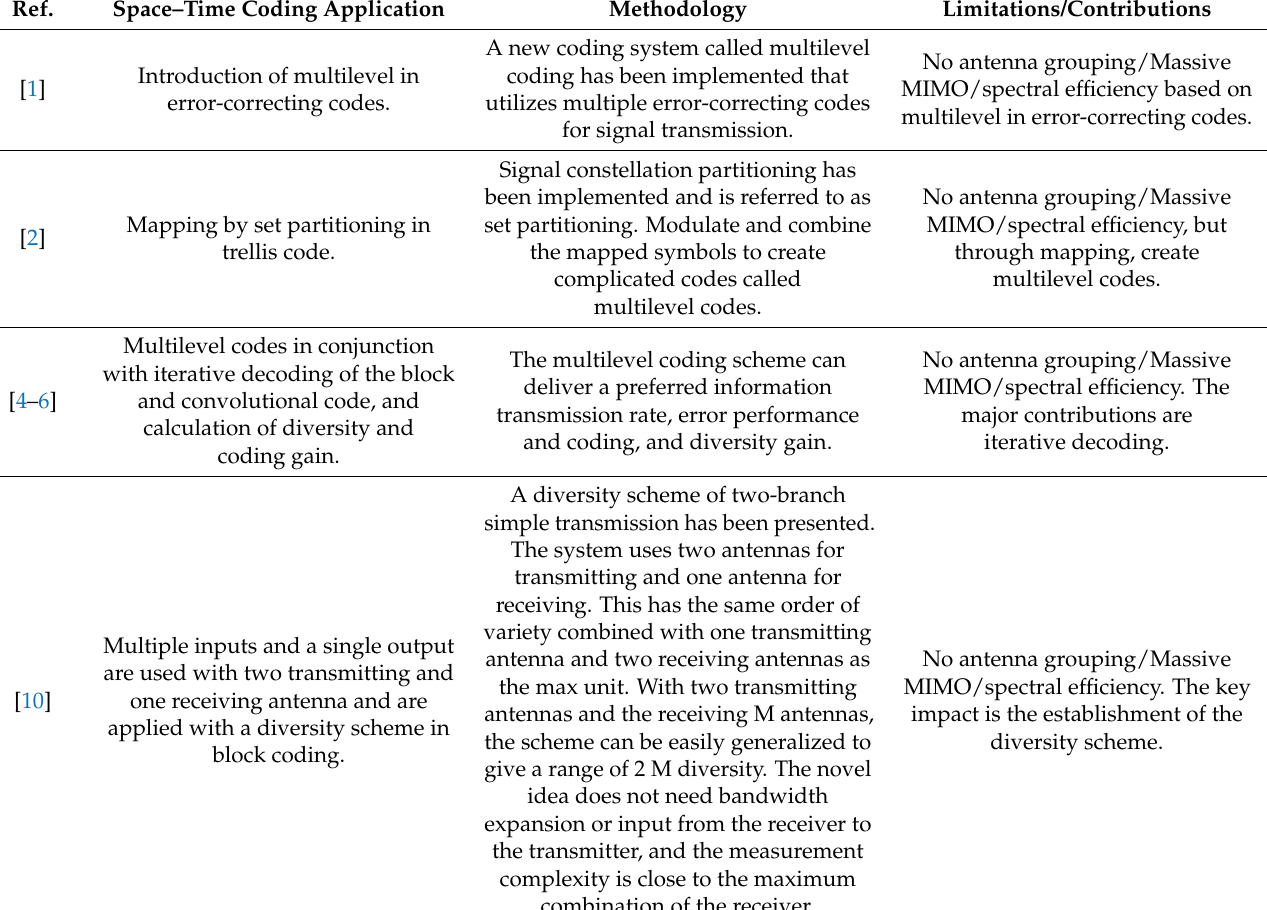
Table 1. Investigation of space–time coding, antenna grouping, and their